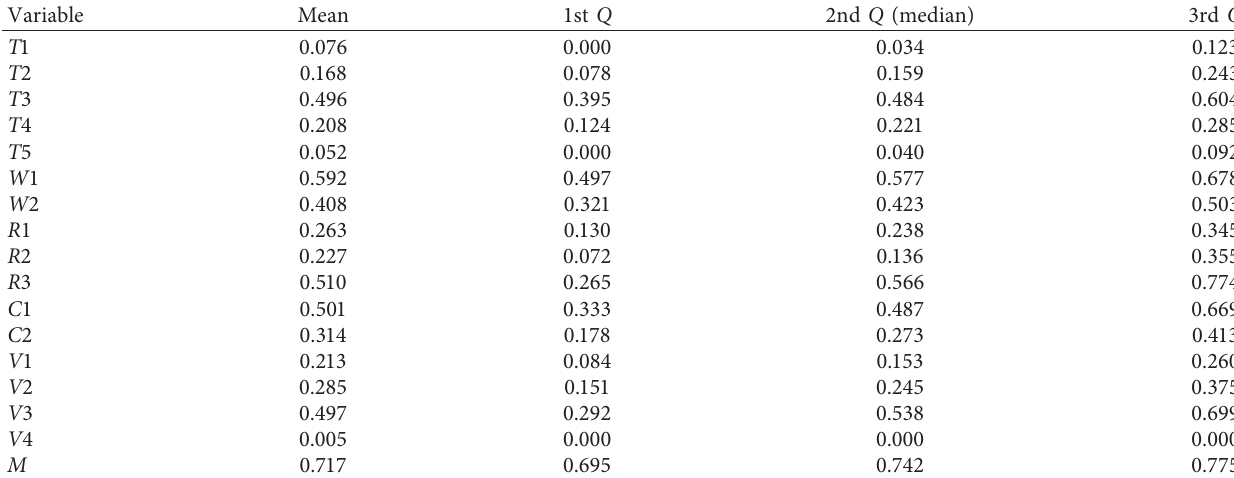
Table 2: Descriptive statistics of all predictor